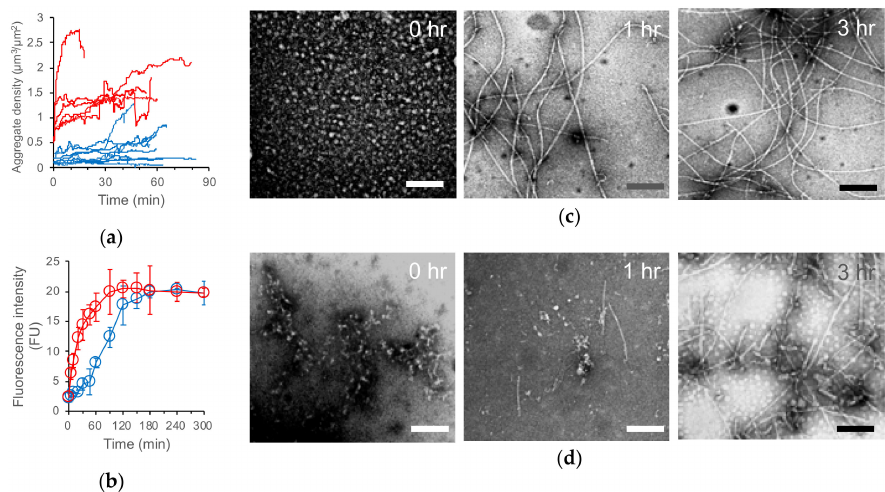
Figure 14. Relationship between HS-AFM observation, thioflavin T (ThT) assay, and transmission electron microscopy (TEM) of LMW and HMW A β 42 incubation. The time evolution of the total A β 42 aggregate density in HS-AFM observation ( a ); time course of ThT fluorescence intensity ( b ); TEM images of LMW ( c ; blue lines in ( a , b )) and HMW (( d ); red lines in ( a , b )) A β 42 incubations. Bars, 100 nm. Reproduced from